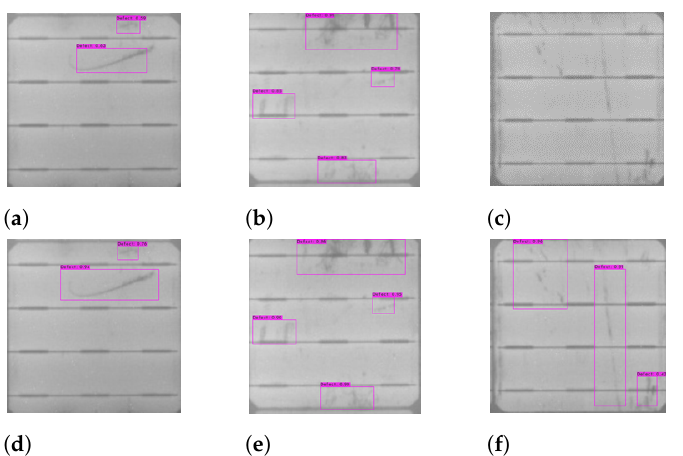
Figure 16. The defect detection results of cell images by ( a – c ) YOLOv3 and ( d – f )